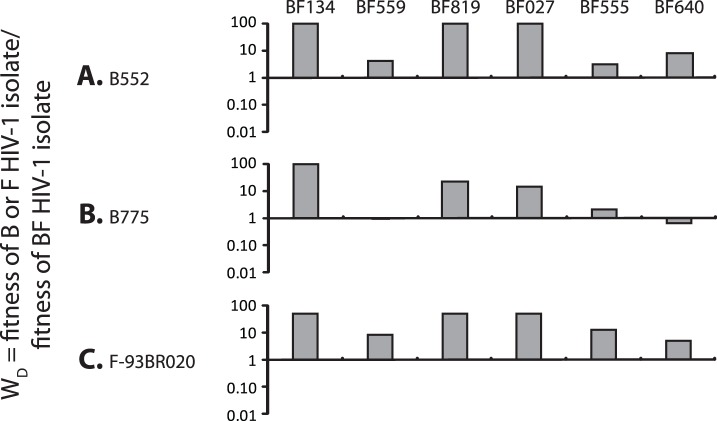
Comparing the relative replicative fitness difference (WD) of syncytium inducing (SI) HIV-1 Argentinean subtype B (a) B552, (b) B775 and (c) reference subtype F, 93BR020 against BF Argentinean recombinants (BF134; BF559; BF819, BF027, BF555 and BF640) in direct competitions using PHA/IL2 PBMCs.Bars represent the fitness of the viruses shown on the Y-axis.